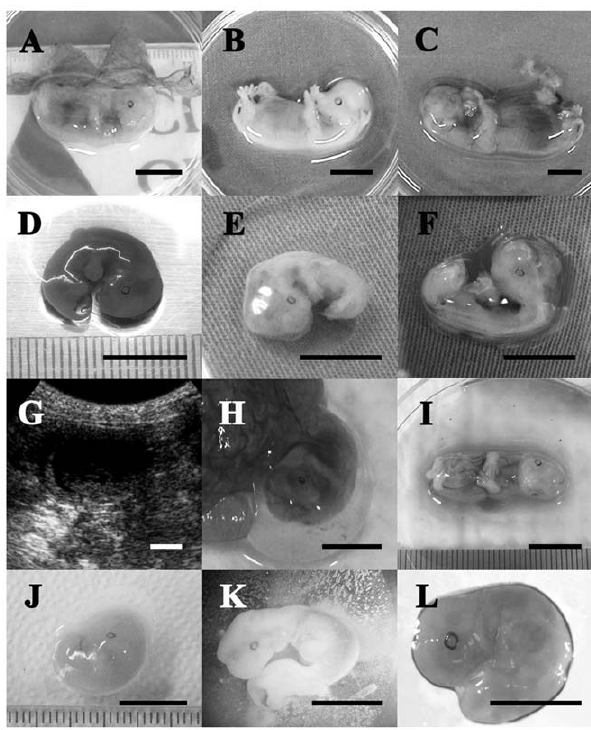
Figure 2. Comparison of control and parthenogenetic canine fetuses. (A–C) The relative size and gross morphology of a control fetus on days 28, 30 and 32 of pregnancy, respectively. (D–F) Parthenogenetic fetuses on day 28 of pregnancy. (G) In utero ultrasonograph of parthenogenetic fetuses on day 29 of pregnancy. (H, I) A parthenogenetic fetus recovered on day 30 of pregnancy. Note that the vascular system is well developed and the external morphology is similar to the control. (J) Another small parthenogenetic fetus recovered on day 30 of pregnancy. (K, L) Parthenogenetic fetuses recovered on day 32 of pregnancy. All scale bars represent 10